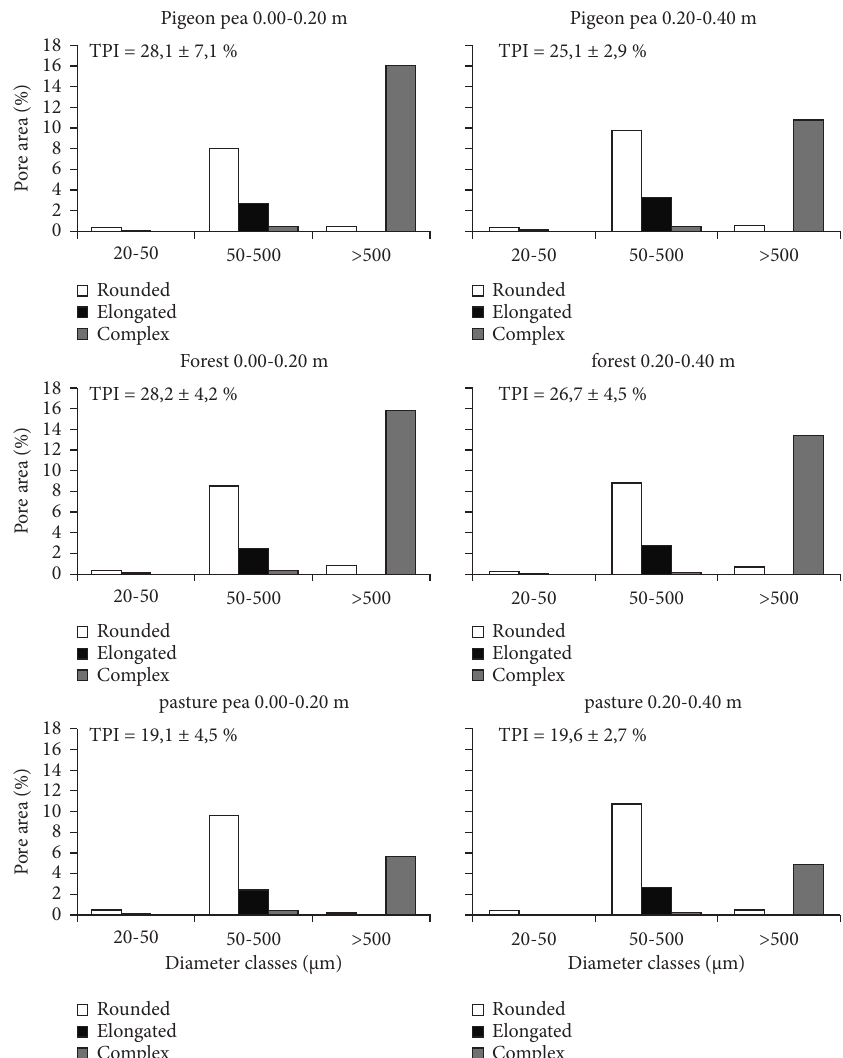
Figure 2: Pore areas according to shape and size from ADE areas with pigeon pea, pasture, and native forest, in soil layer of 0.00–0.20m and 0.20–0.40m. TPI � total pore area per